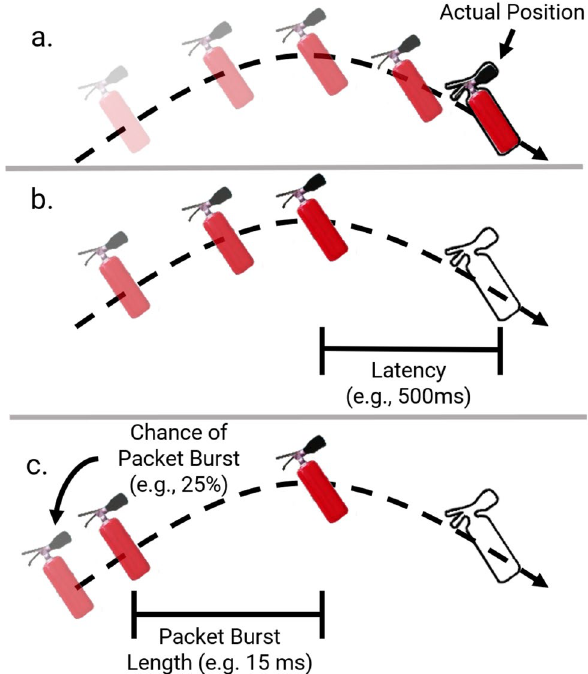
Figure 3. An illustration of the different preset behaviors. The outlined extinguisher represents the actual location (as defined by the authority of the extinguisher). The translucency corresponds to the recency of each position. Figures: ( a ) control (no latency or packet bursts, ( b ) latency but no packet bursts, and ( c ) latency and packet